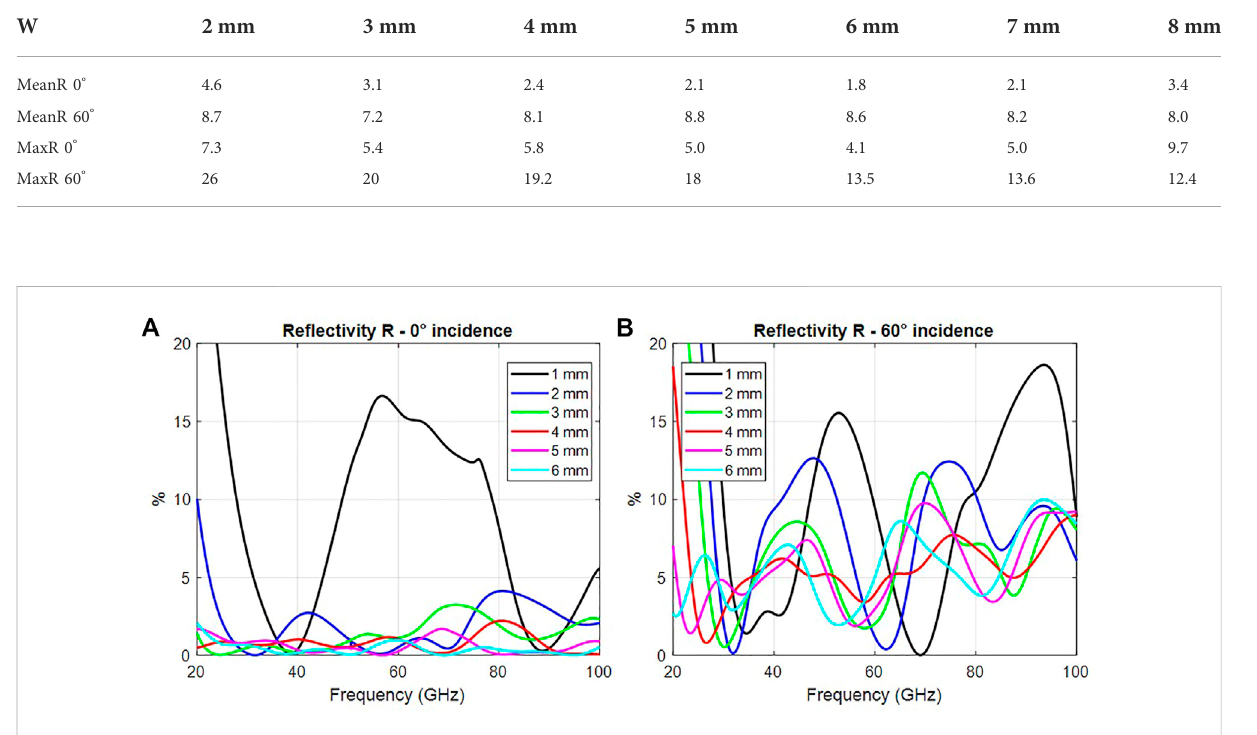
TABLE 2 Mean and maximum values of re fl ectivity R as a function of width W and for the angle of incidence 0 ° and 60 °